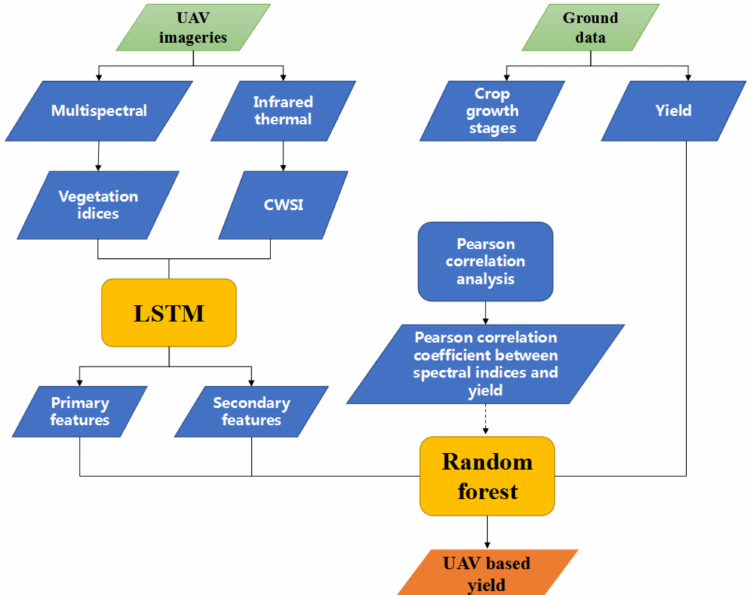
Figure 2. Methodological flowchart for crop yield prediction from the unmanned aerial vehicle (UAV) imageries in combination with ground-based data.